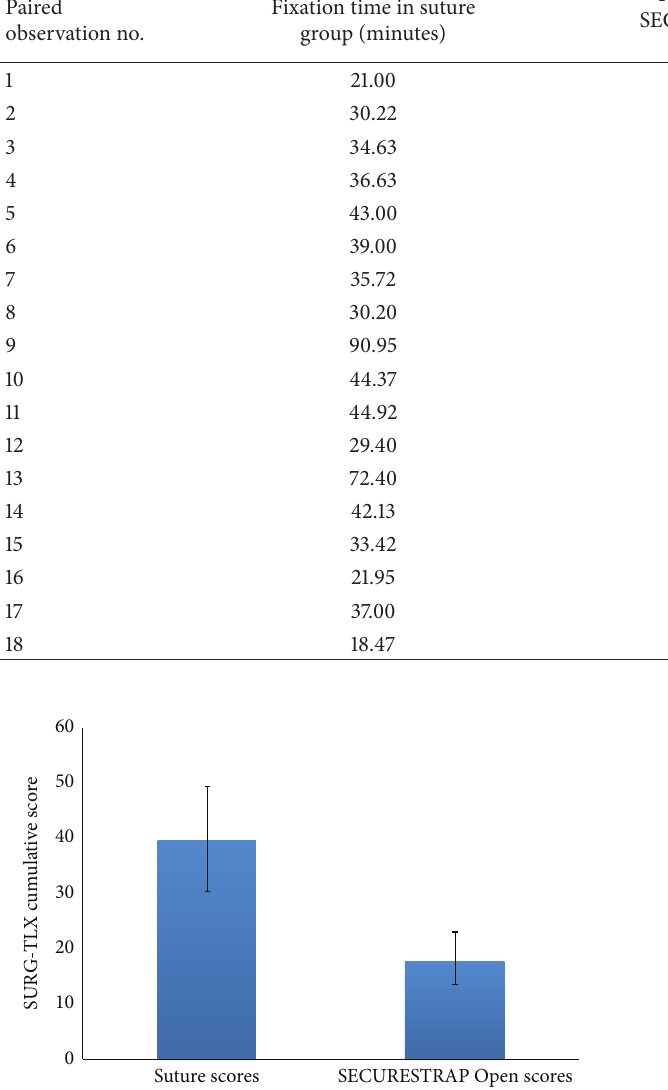
Figure 2: Task load (SURG-TLX) scores for suture and mechanical fixation groups.